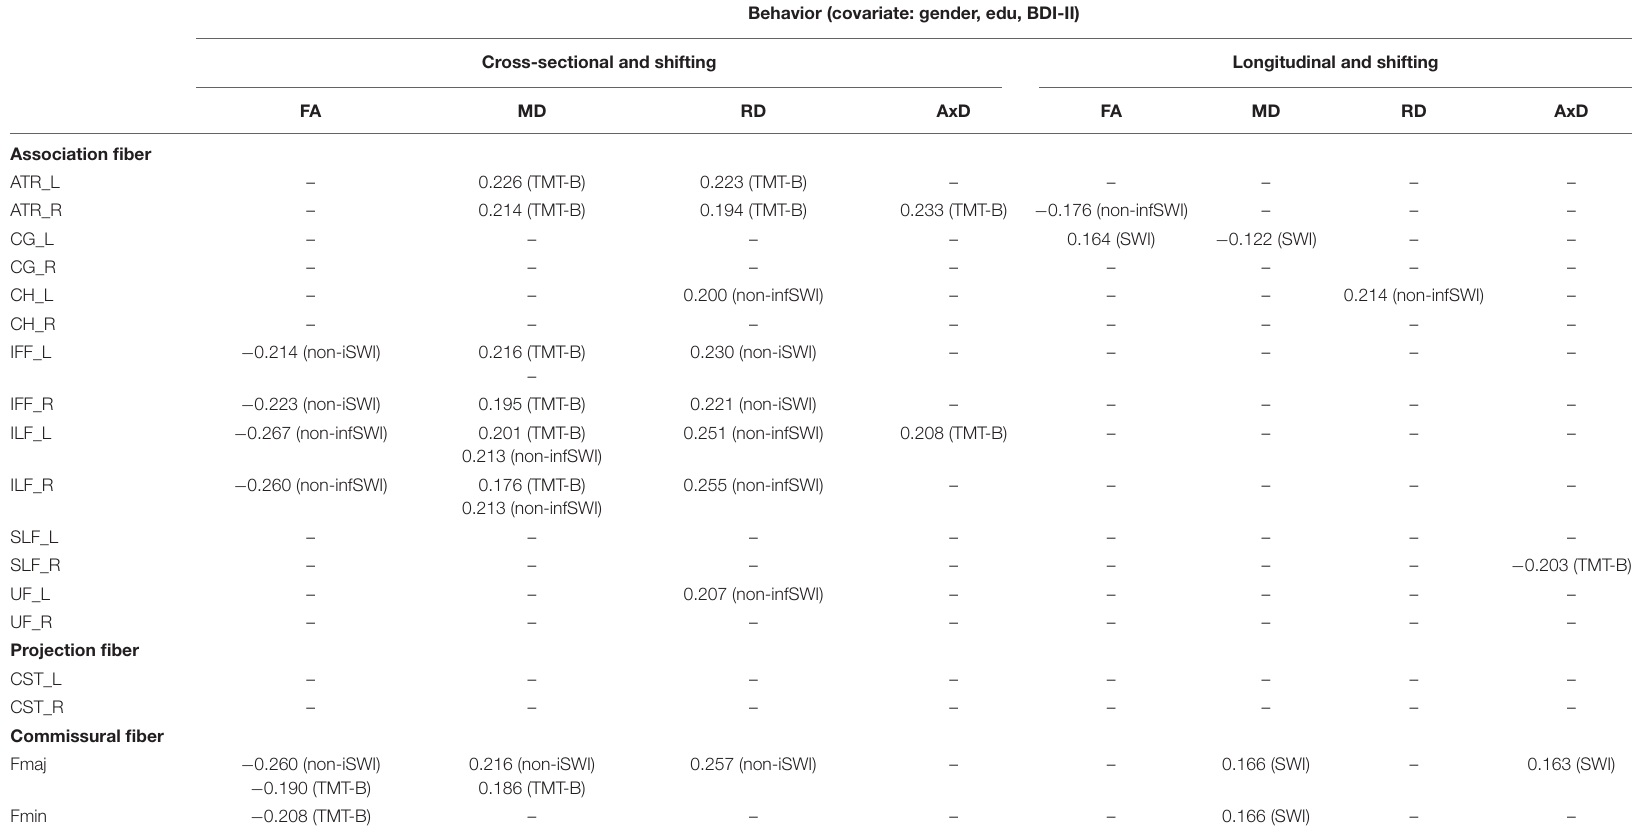
TABLE 6 | The significant Pearson correlation r values for the shifting component in relation to DTI measures (FA, MD, RD, and AxD) for cross-sectional and longitudinal ratio scores. Behavior (covariate: gender, edu, BDI-II) Cross-sectional and shifting Longitudinal and